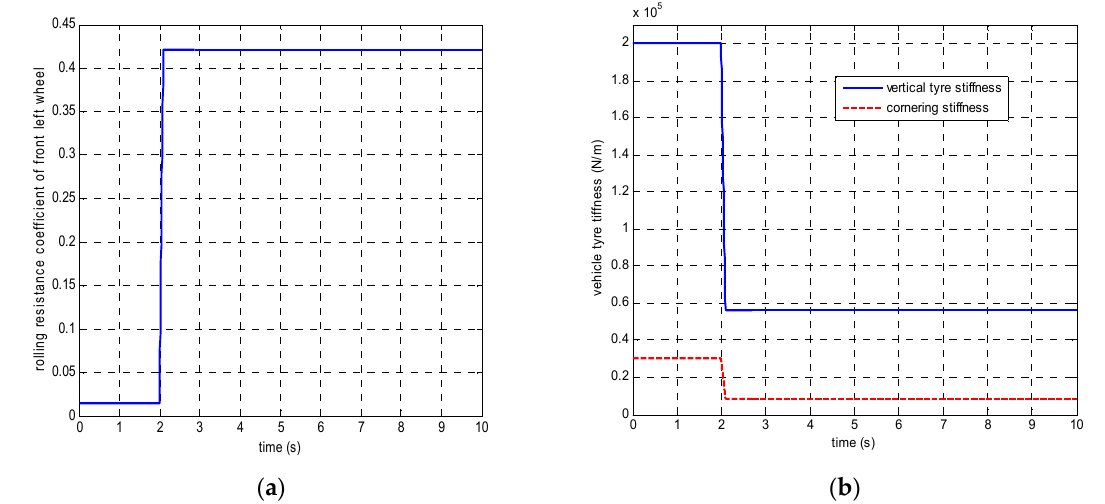
Figure 9. The changing of front-left tyre parameter after tyre blow-out ( a ) rolling resistance coefficient ( b ) tyre stiffness.